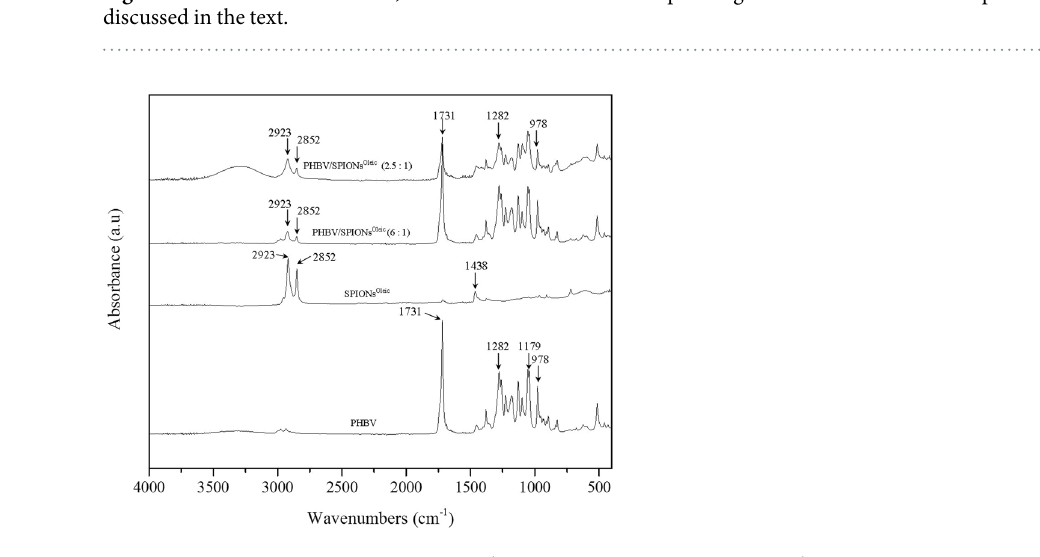
Figure 4. FTIR results on PHBV, SPIONs Oleic and PHBV containing SPIONs Oleic . The characteristic peaks are discussed in the